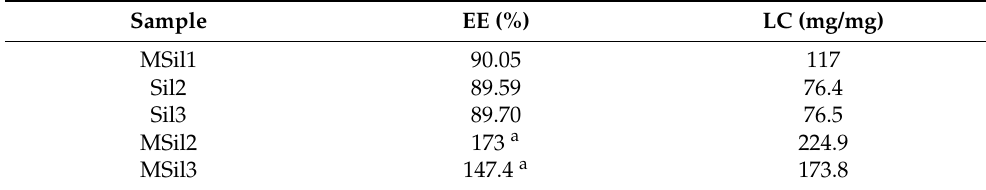
Table 3. Maximum encapsulation efficiency and loading capacity of doxorubicin in silica.